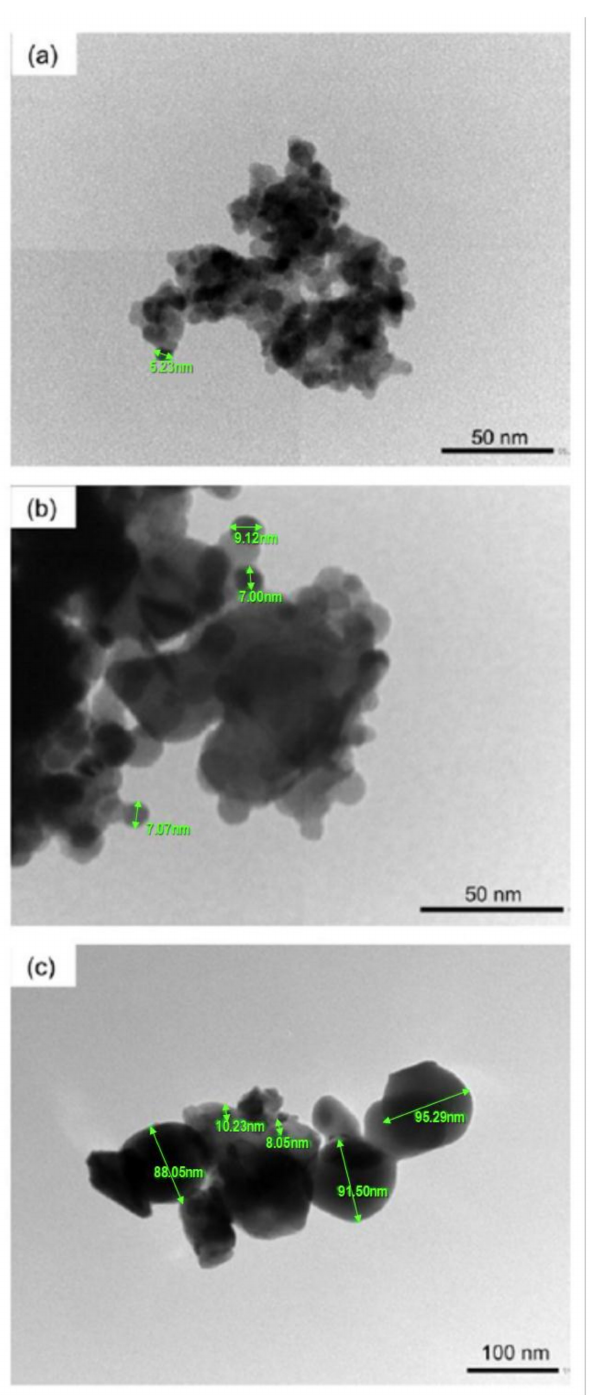
Figure 4. TEM images of reduced catalysts: ( a ) NiMoRe/GDC, ( b ) NiMoCu/GDC, ( c )